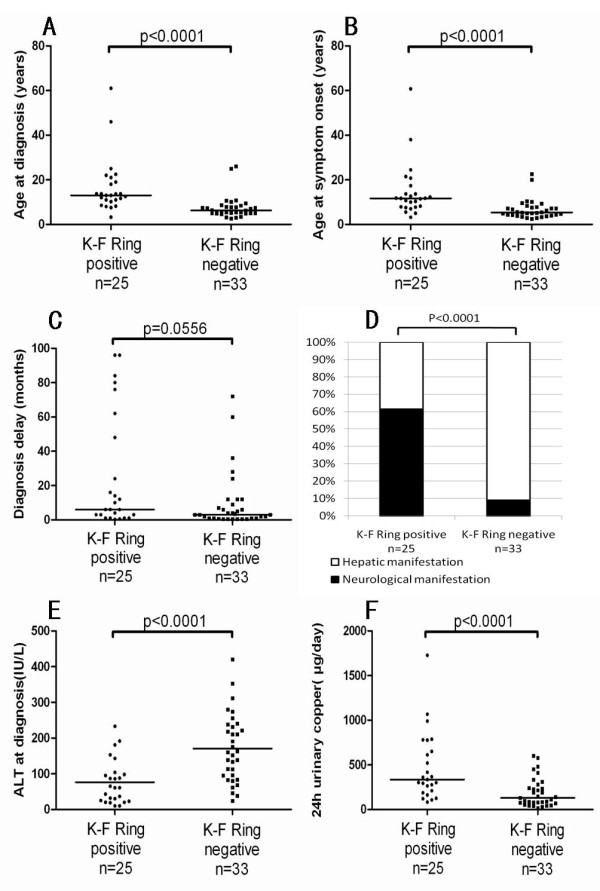
Correlation of cornea Kayser-Fleischer (K-F) ring with age at diagnosis (A), age at symptom onset (B), diagnostic delay (C), corneal K-F Ring (D), ALT levels at diagnosis (E) and 24-h urinary copper levels at diagnosis (F) in Chinese patients with Wilson's disease.